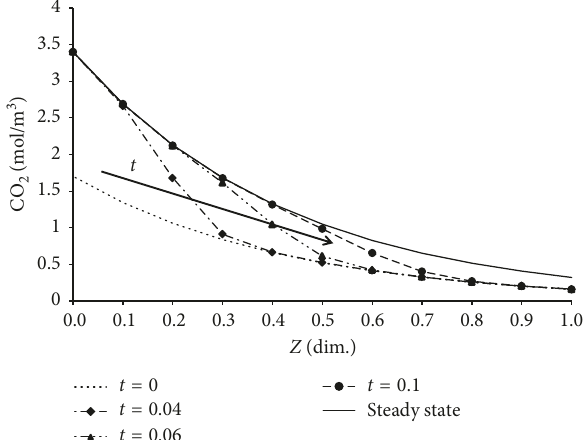
Figure 8: Dynamic change of the CO bling the input CO 2